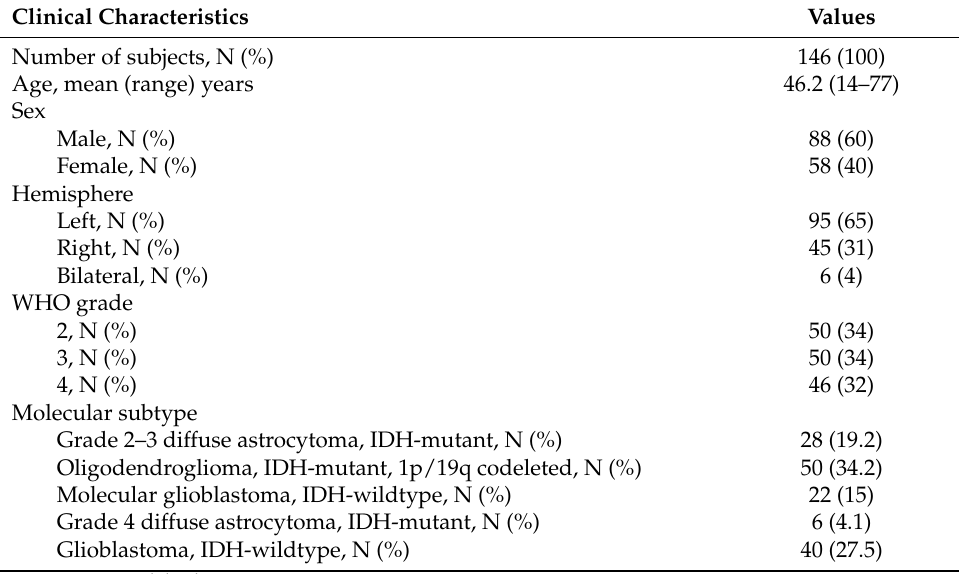
Table 1. Demographic and clinical data of the patient